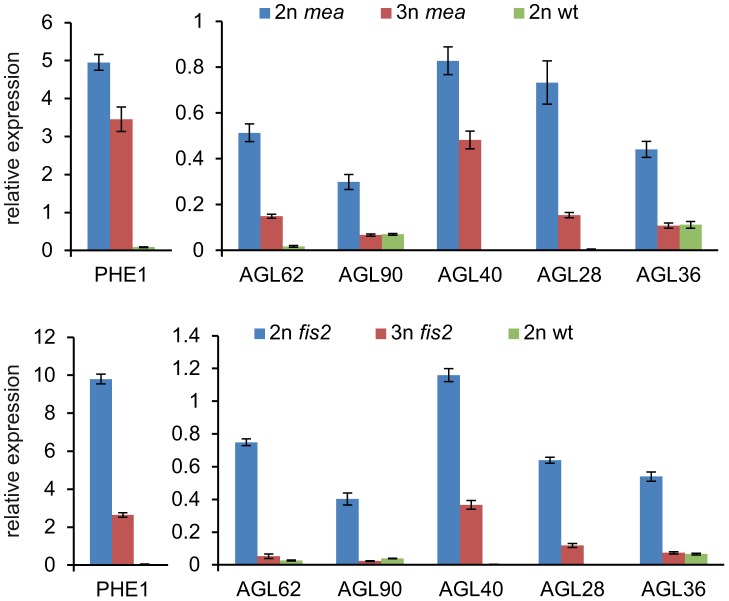
Expression of AGL MADS Box Genes Is Normalized in Triploid mea and fis2 Seeds.Quantitative RT-PCR analysis of AGL62, PHE1, AGL90, AGL40, AGL28 and AGL36 at 8 DAP in mea and fis2 seeds (upper and lower panel, respectively). Enlarged seeds with a fis phenotype were selected as 3n mea and fis2 seeds from mea/MEA; osd1/osd1×2n and fis2/FIS2; osd1/osd1×2n crosses, respectively. Diploid mea seeds are a mixture of wild-type and mea seeds. Error bars indicate s.e.m.